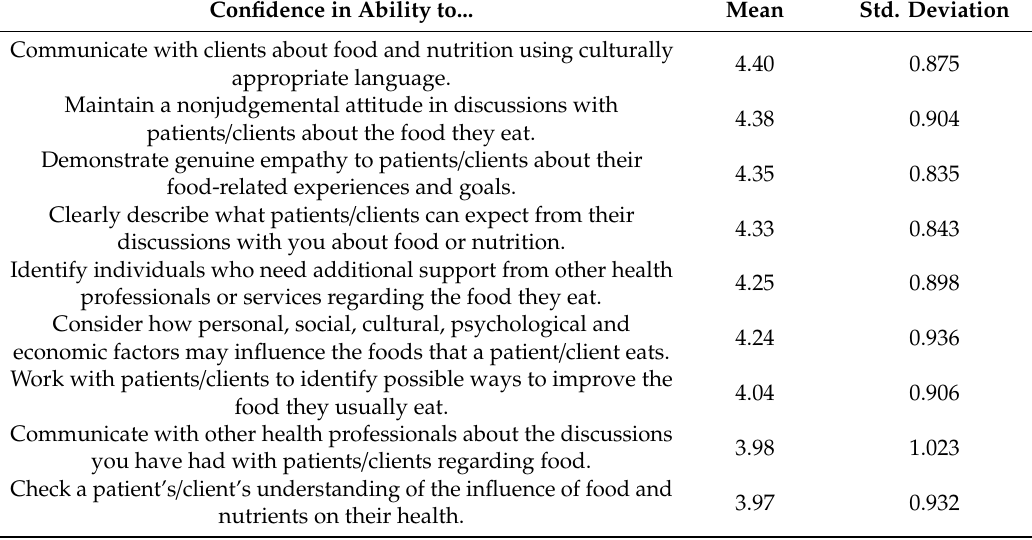
Table 6. Self-reported confidence in communication and counselling about nutrition, measured on a 1–5 Likert scale (1—absolutely not agree and 5—totally agree) in descending ordering, according to mean value.